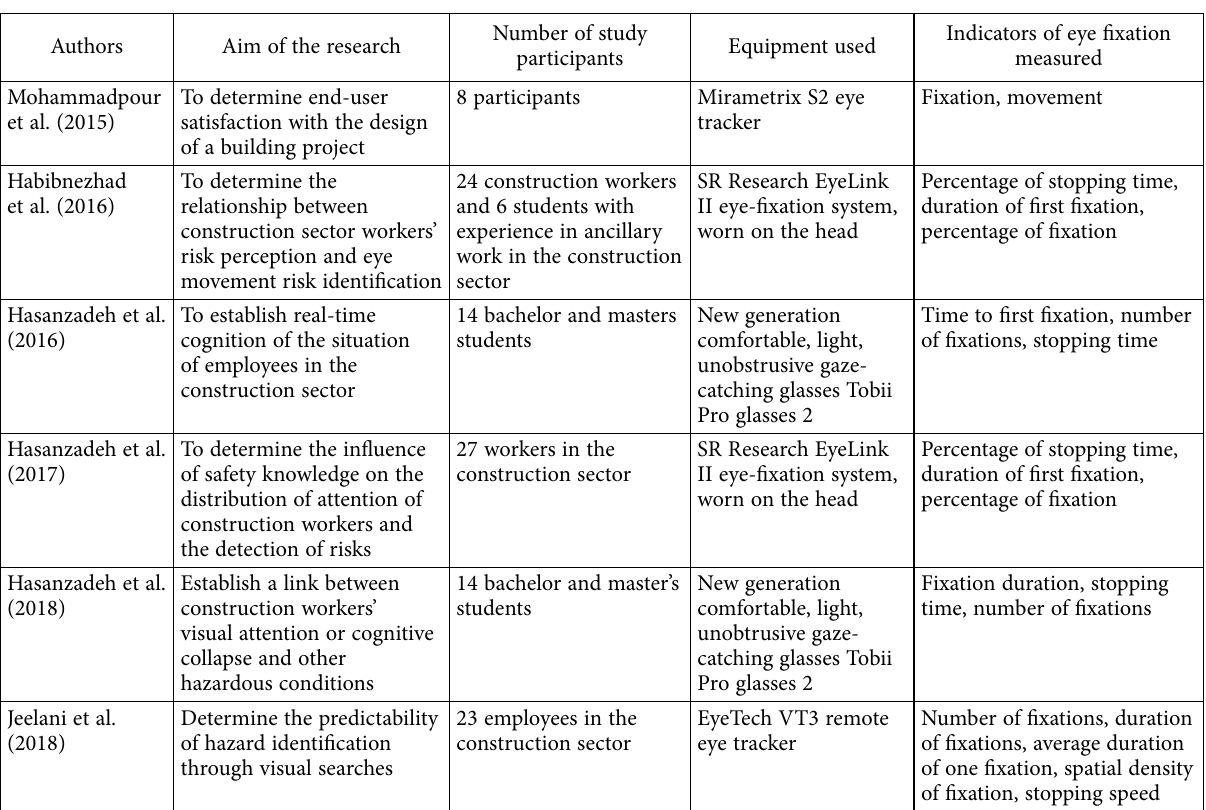
Table 3. Researches employing eye tracking